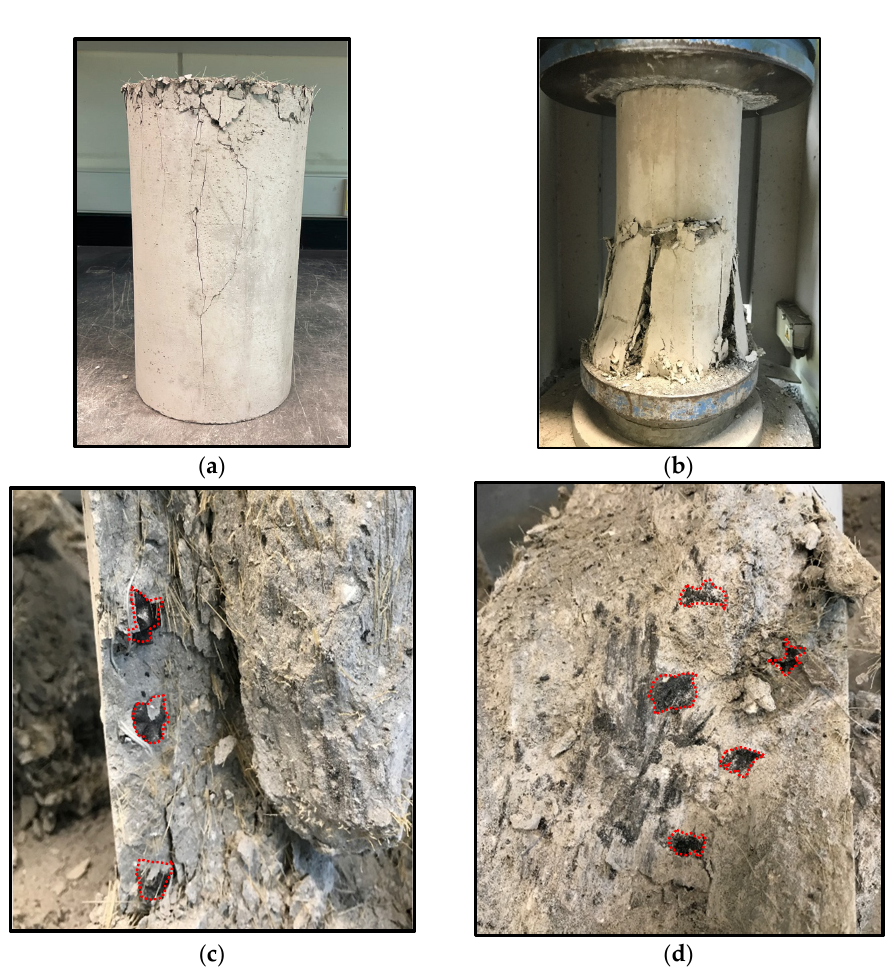
Figure 8. Failure pattern of OBA ‐ RECC ( a ) Longitudinal cracks on the sample ( b ) larger sample cracks at a higher load ( c ) and ( d ) Failed samples showing a good bonding between the OBA and the hardened matrix.